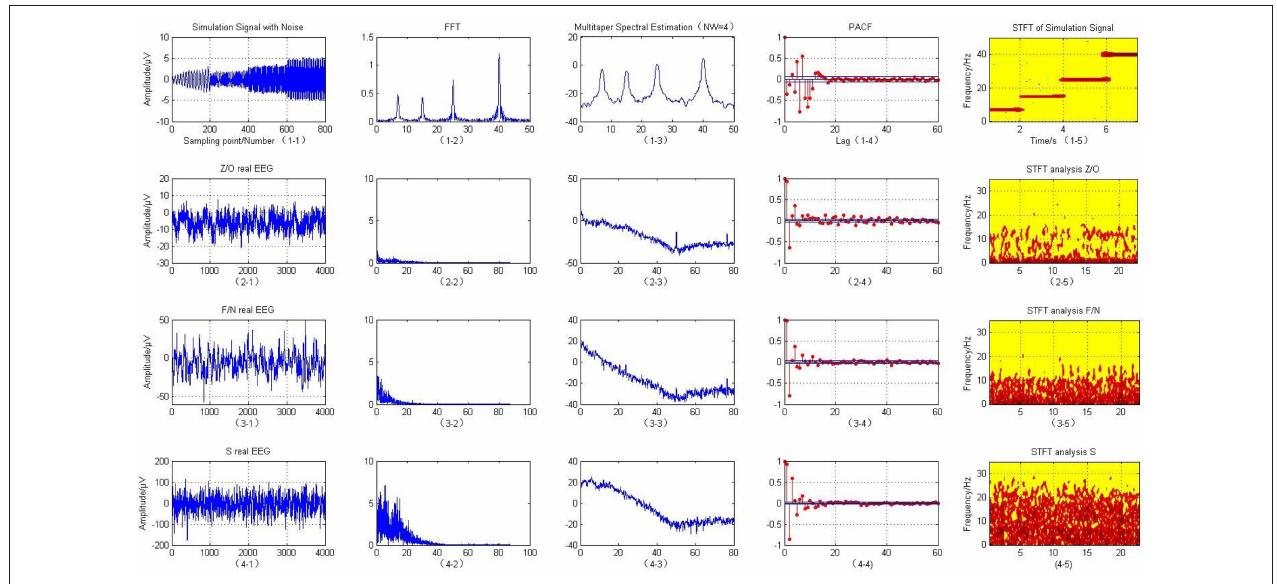
FIGURE 2 | T-F analysis of simulated and actual clinical EEG data.